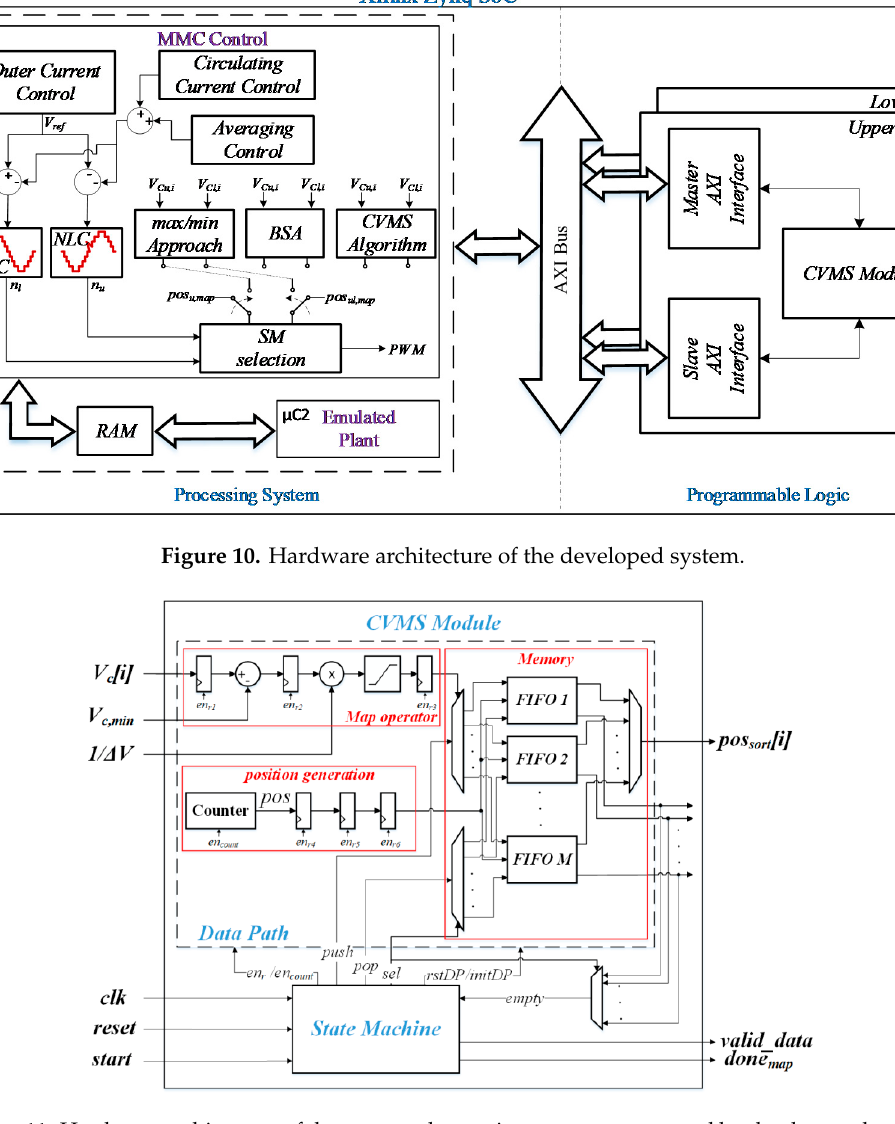
Figure 11. Hardware architecture of the proposed mapping strategy composed by the data path and the state machine. The data path consists of the map operator, the memory block and the position